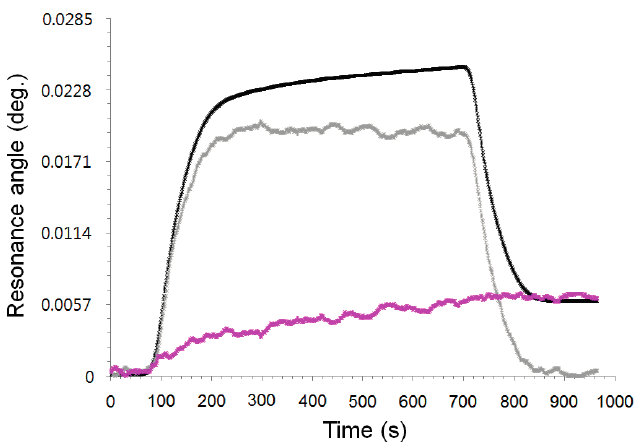
Figure 8. Sensorgrams obtained by measuring θ RA (black solid line), θ CA (gray solid line), and θ SAA (pink solid line) in real time on binding, diluted BSA-glycerin mixture in PBS buffer solution on bare gold sensor